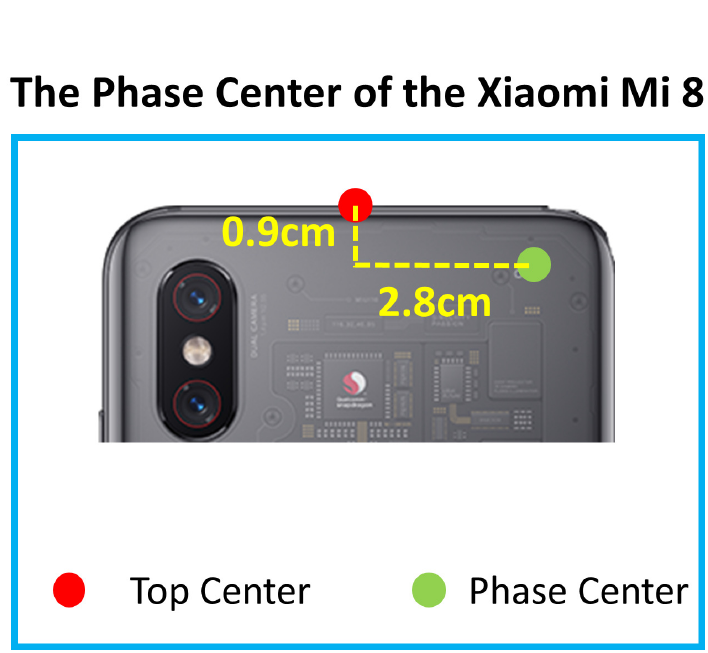
Figure 7. Devices and environments. ( a ) Devices. ( b ) Buildings to the south of the playground.